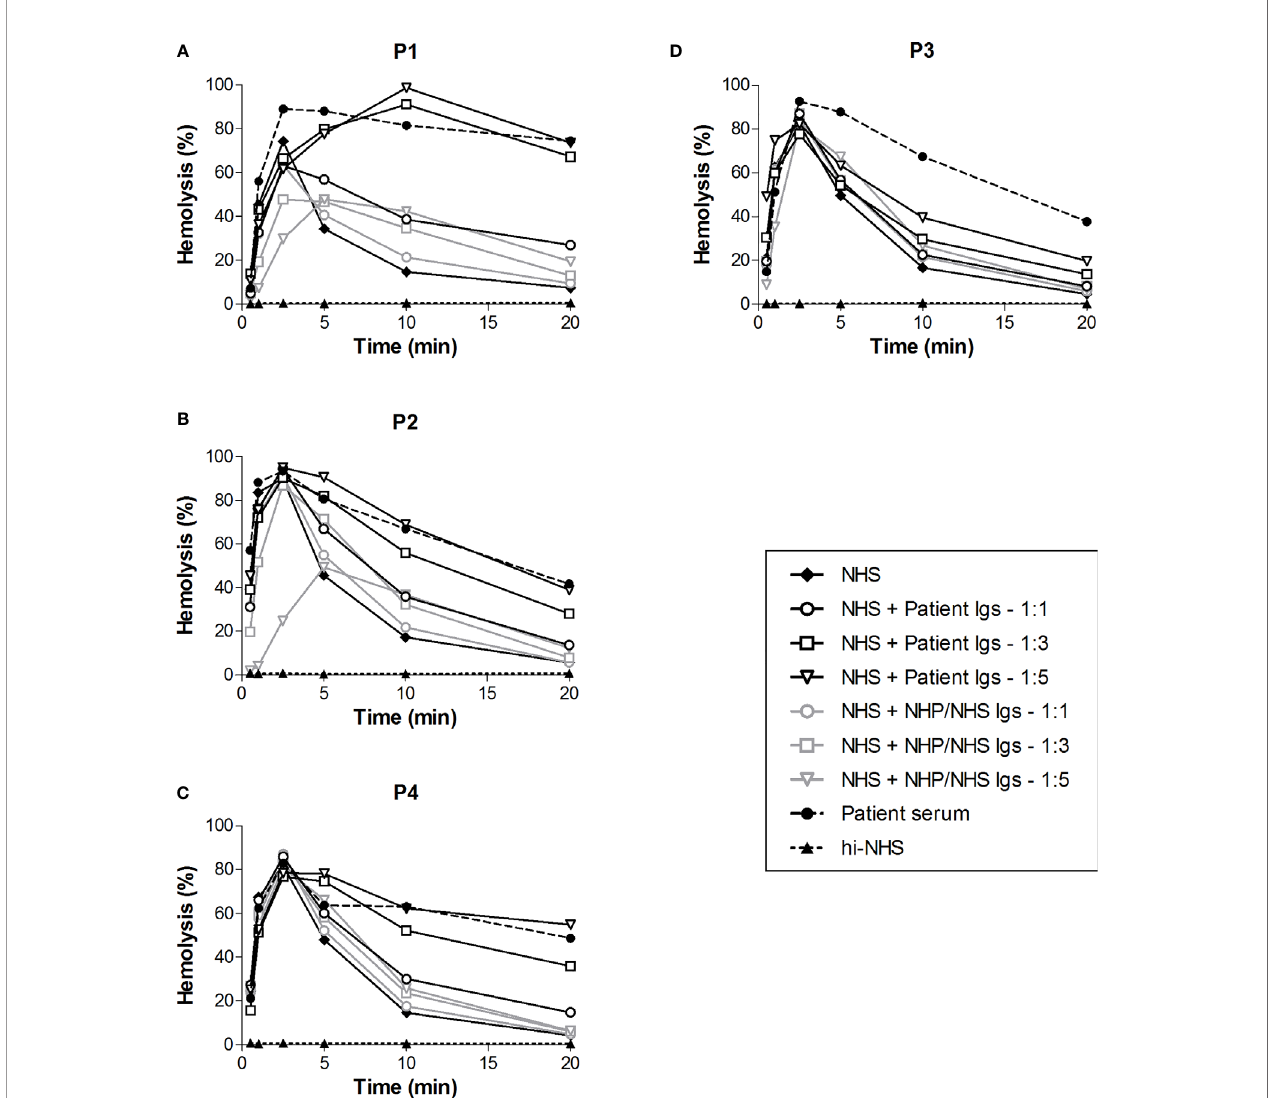
FIGURE 4 | Classical pathway convertase activity pro fi les of control serum supplemented with patient immunoglobulin fractions. Sensitized sheep erythrocytes were incubated with normal human serum (NHS) mixed with an equal (1:1) or excess volume (1:3 and 1:5) of immunoglobulins (Igs) puri fi ed from the EDTA-plasma of patient P1 (A) and P4 (C) or from the serum of P2 (B) and P3 (D) . As a negative control, Igs puri fi ed from normal human plasma (NHP) or NHS, depending on the source of the patient Igs, were added in similar ratios. The patient sera were used as positive controls. Hemolysis levels are presented as percentage of full lysis of erythrocytes in water. Concentration series were tested once. hi-NHS, heat-inactivated